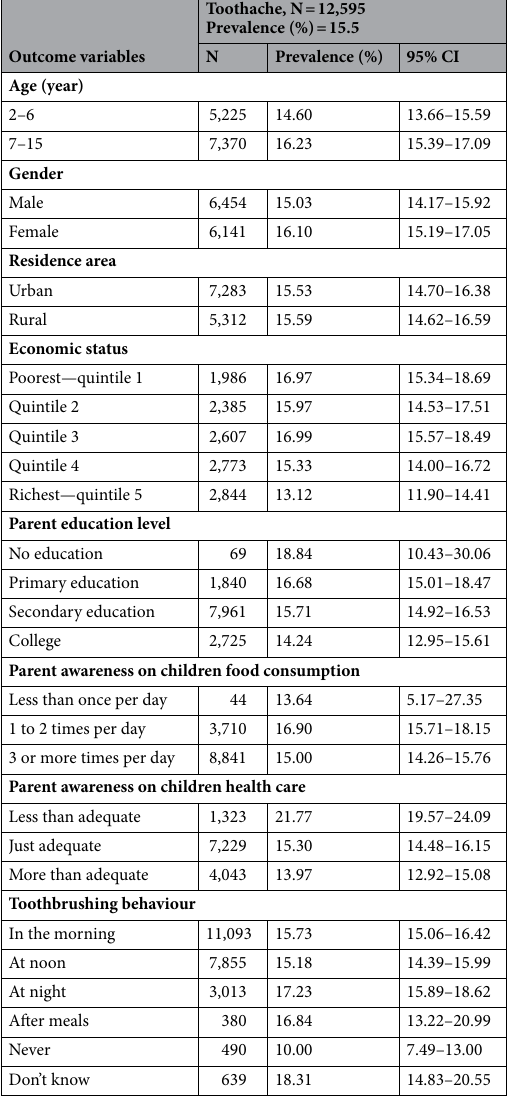
Table 2. Summary statistics for outcome and control variables by toothache among children in Indonesia,